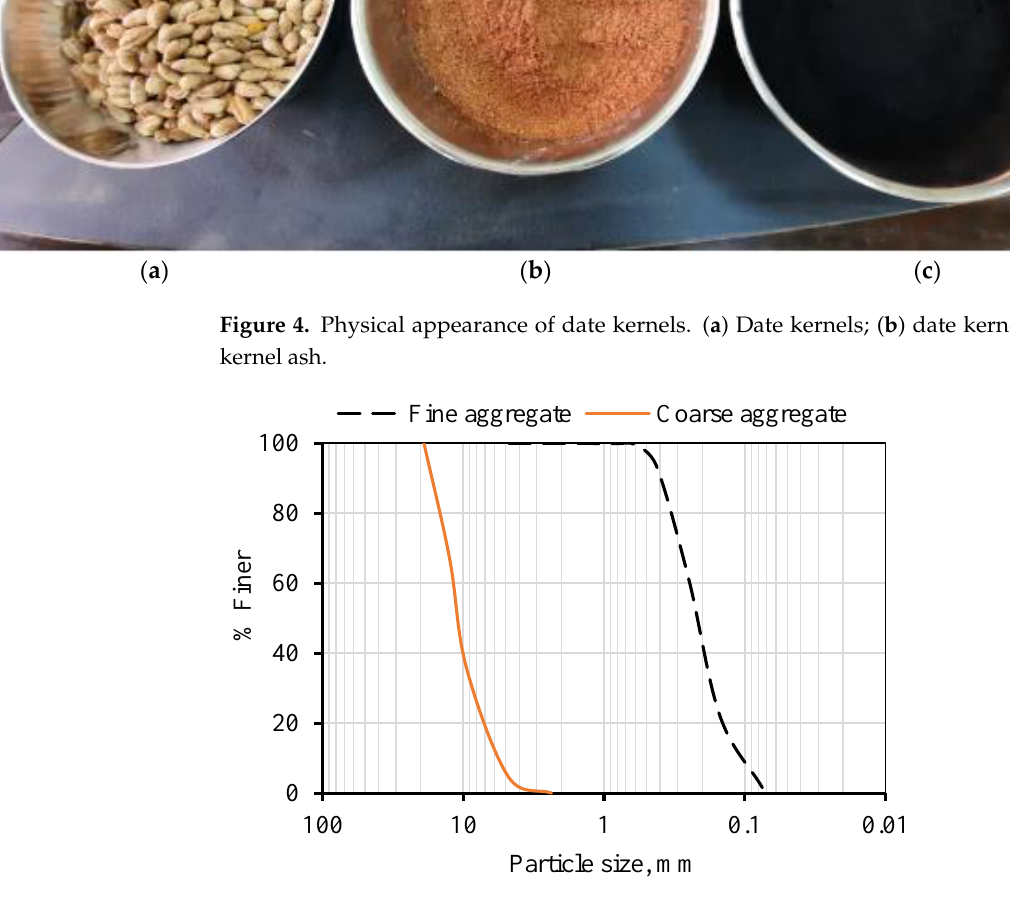
Figure 5. Particle size distributions of fine aggregate and coarse aggregate. Table 2. Physical properties of DKA, FA, and